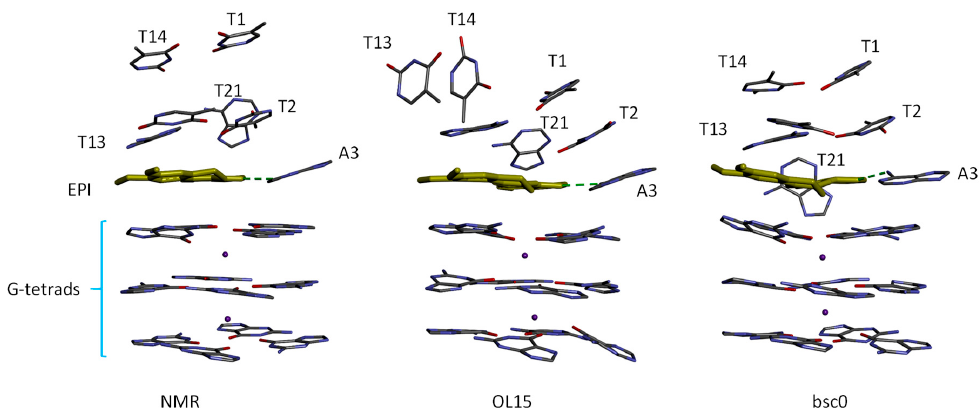
Figure 5. Comparison of the ( left ) NMR structure with the MD snapshots taken at 10 ns from the simulations using ( center ) OL15 and ( right ) bsc0 force field parameters. For clarity, only the nucleotide bases forming the 5 (cid:48) binding site and the G-tetrads are displayed. The green dashed line indicates the EPI-A3 hydrogen